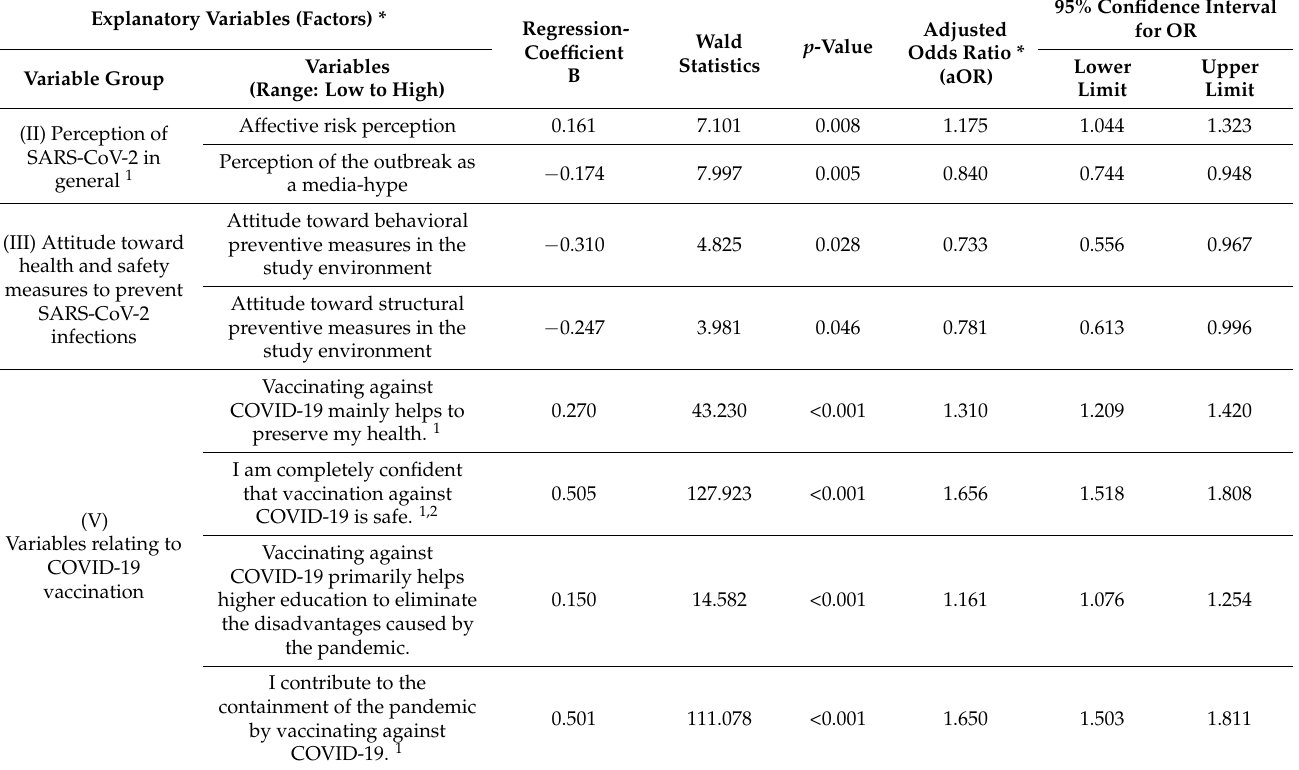
Table 3. Multivariate binary logistic regression analysis: possible explanatory variables (factors) and the outcome “COVID-19 vaccination status” (not vaccinated against COVID-19/received at least one dose of COVID-19